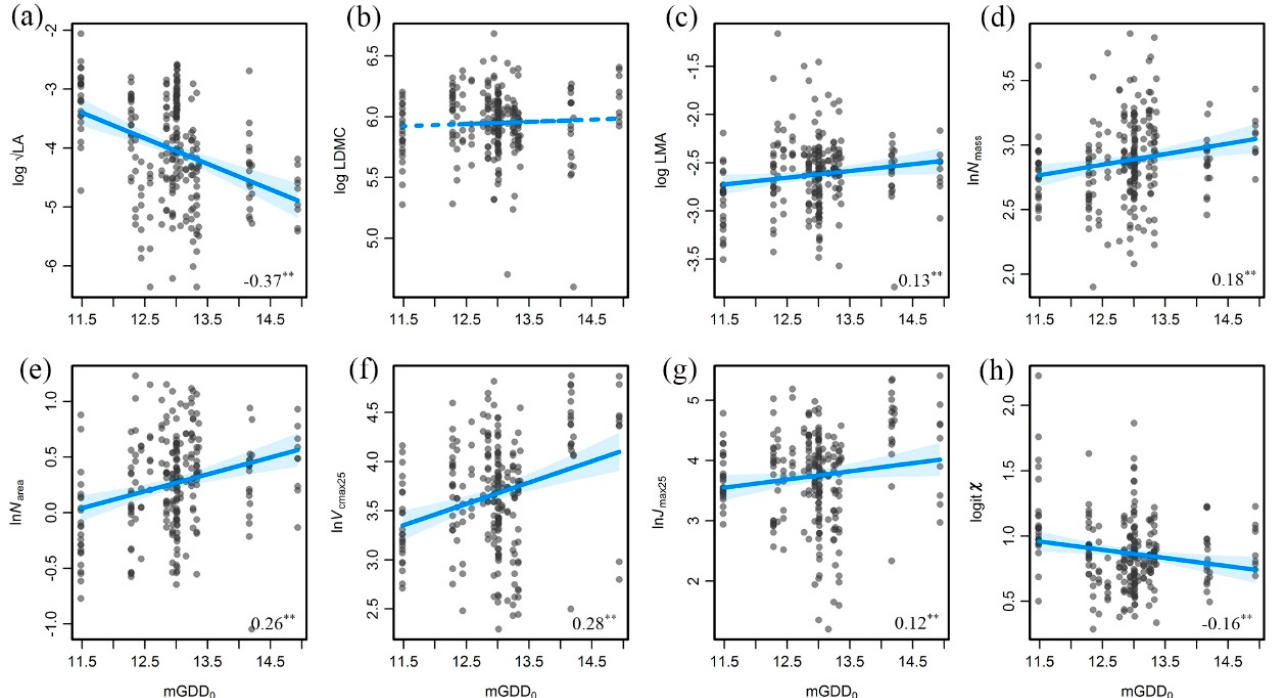
Figure 5. Trait variations along the temperature gradient (growing-season monthly mean temperature above 0 ◦ C, mGDD 0 ). ( a ) LA versus mGDD 0 . ( b ) LDMC versus mGDD 0 . ( c ) LMA versus mGDD 0 . ( d ) N mass versus mGDD 0 . ( e ) N area versus mGDD 0 . ( f ) V cmax25 versus mGDD 0 . ( g ) J max25 versus mGDD 0 . ( h ) χ versus mGDD 0 . The bottom right numbers are the correlation coefficients and their significance, with “**” indicating p < 0.01. LA: leaf area; N mass : leaf nitrogen content per mass; N area : leaf nitrogen per area; LMA: leaf mass per area; LDMC: leaf dry mass content; V cmax25 : maximum carboxylation rate standardized to 25 ◦ C; J max25 : maximum electron transport rate standardized to 25 ◦ C; χ : ratio of intercellular to ambient CO 2 concentration.